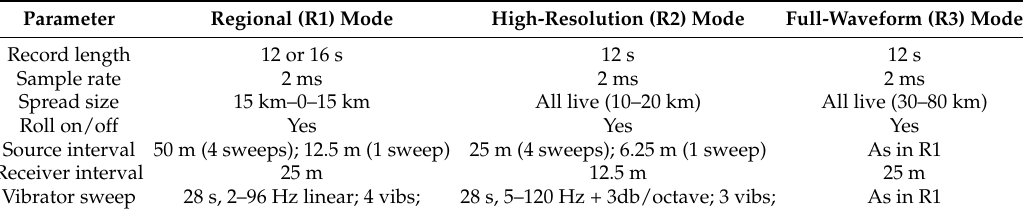
Table 1. Acquisition parameters used in regional, high-resolution, and full-waveform modes.